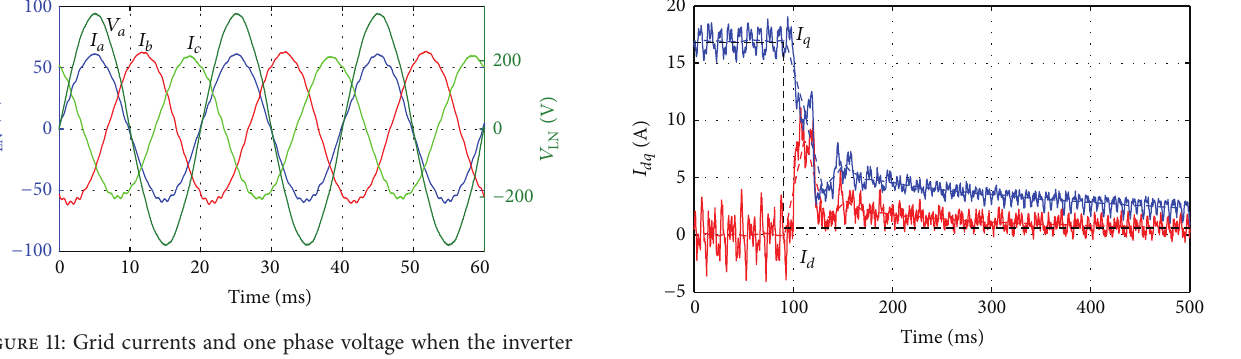
current-control loop, symmetrical filtering may be applied to the measured currents.